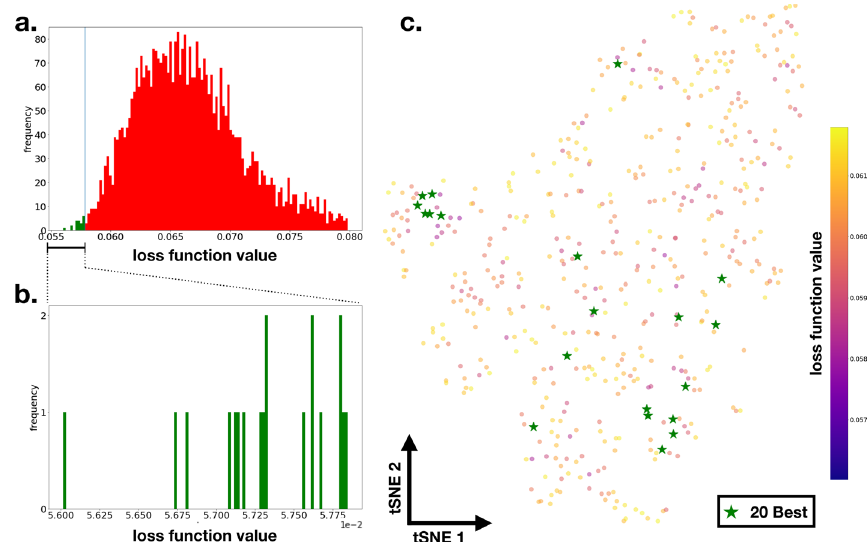
Fig. 2 Distribution of the inferred parameters. a Histogram of the inferred parameters with respect to the loss function. Shaded green shows the best 20 inferred parameters. b Zoomed axes of the histogram showing only the density of the best 20 inferred parameters. c t-SNE embedding of the top 500 inferred parameters, with the loss function colour overlay. The best 20 inferred parameters are marked with green